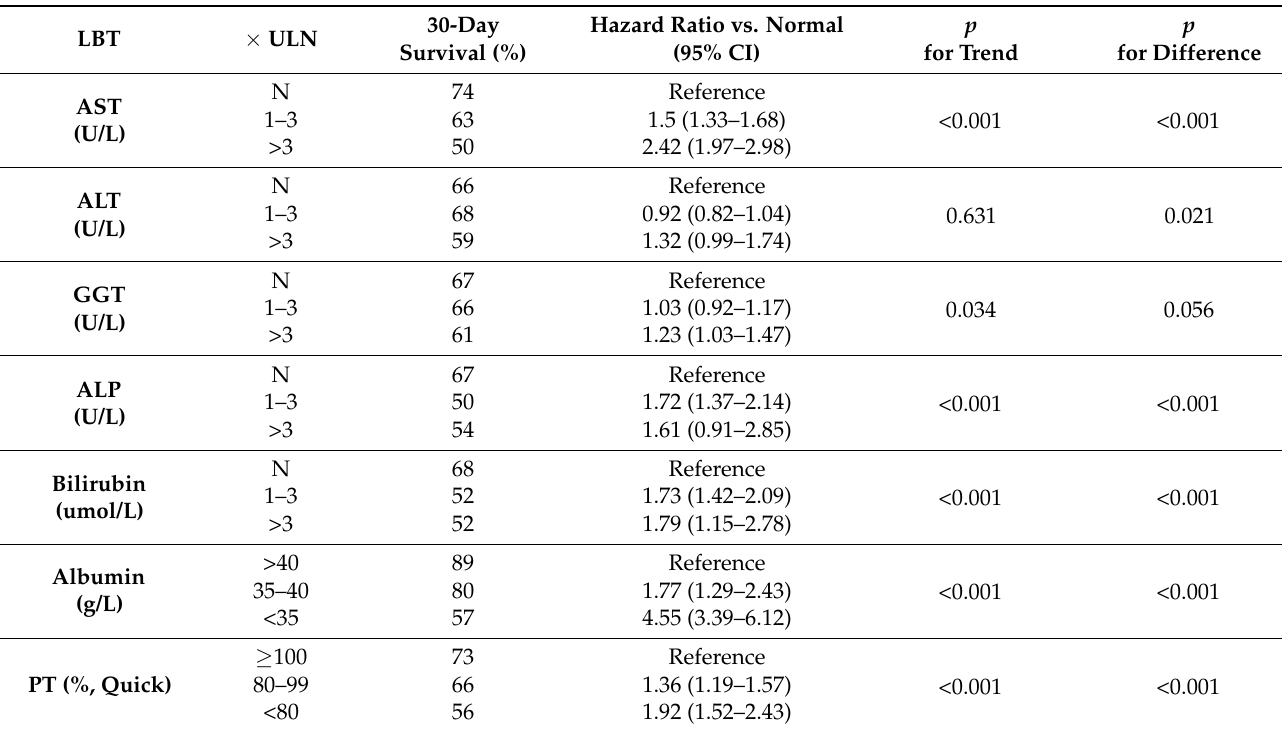
Table 3. Associations of liver blood tests with 30-day